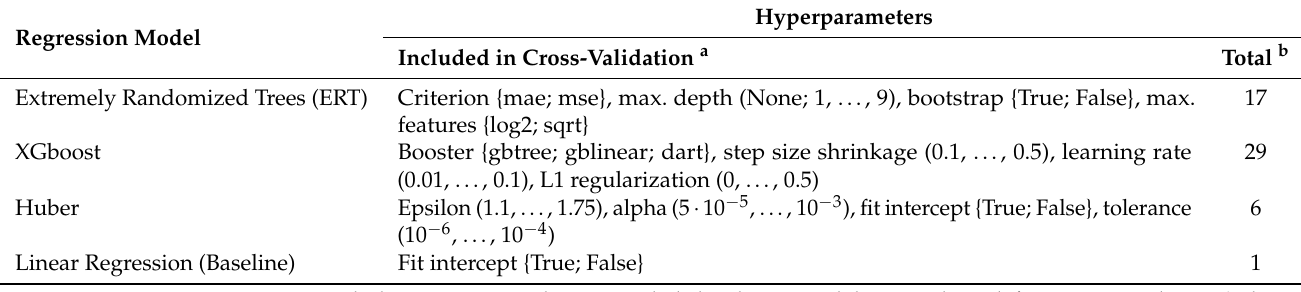
Table 3. The models that were evaluated and the considered